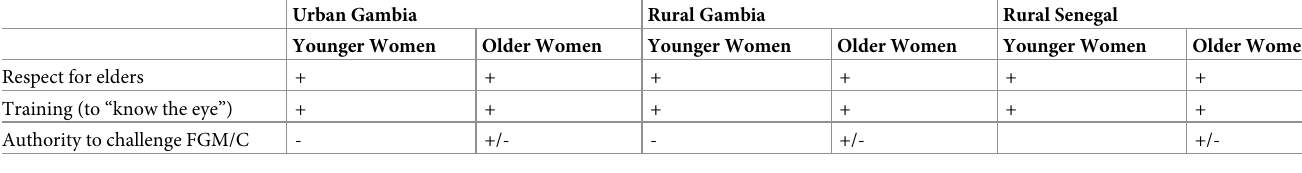
Table 3. Summary matrix of themes related to the overarching theme of upholding social